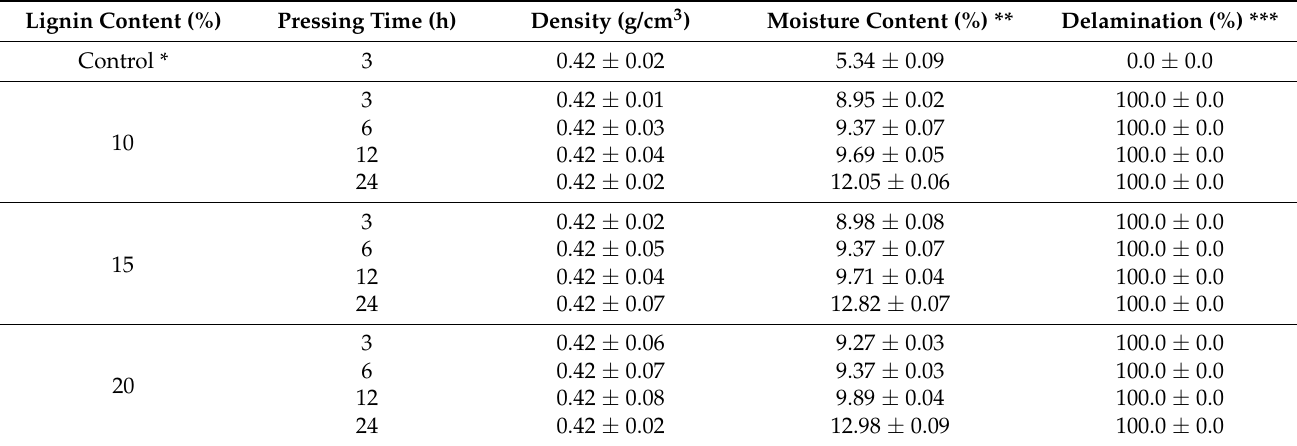
Table 5. Physical properties of plywood bonded with PVOH–lignin–hexamine-based adhesives at different lignin contents and pressing